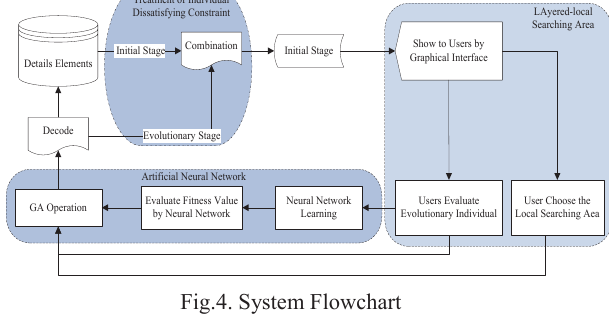
Fig.4. System Flowchart